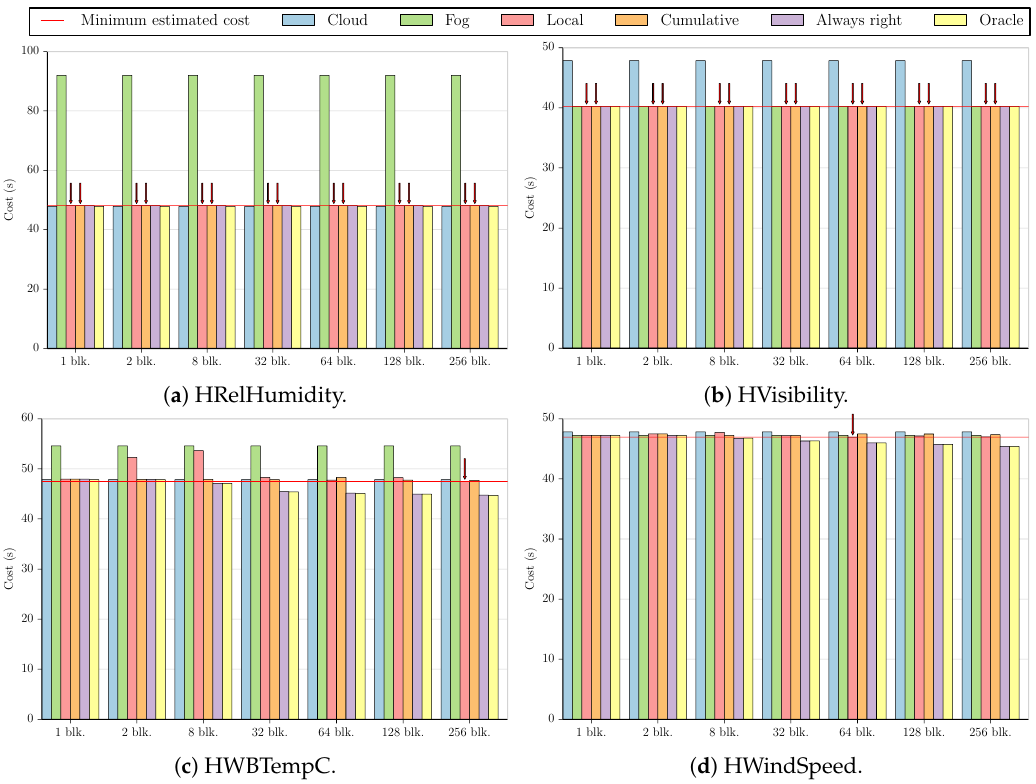
Figure 6. Summary of the results for MinMax [ − 15,15 ] cloud-prone test